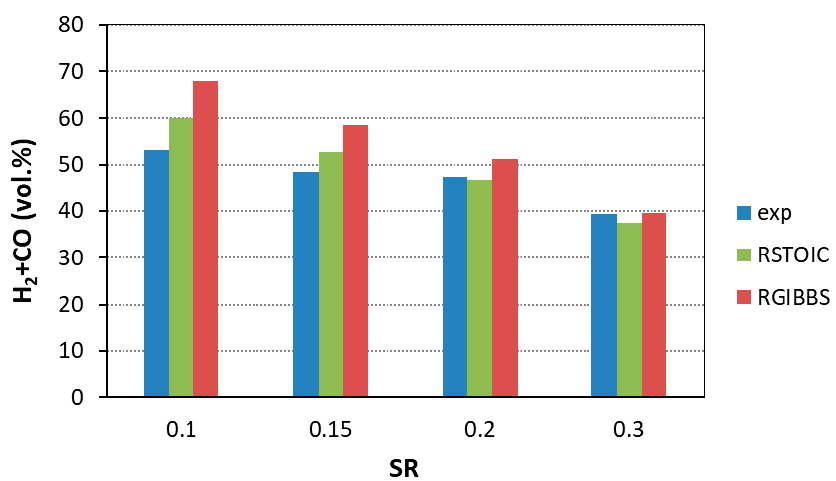
Figure 4. Comparison between experimental and simulation results for the produced syngas composition at different stoichio- metric ratios, for the gasification of PKS with 70 vol.% steam at 900